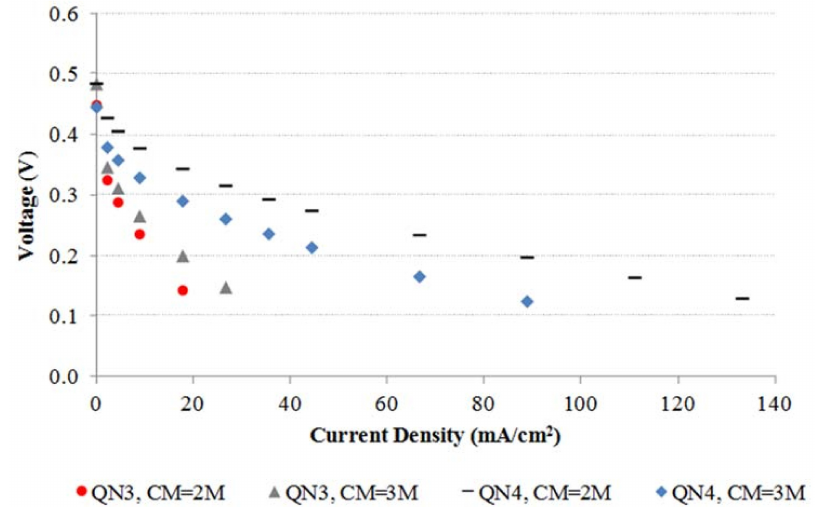
Figure 3. Voltage polarization curves comparison for MEAs QN3 and QN4 for different methanol feed concentrations (CM). Operating conditions: temperature, 25 ◦ C; pressure, 1 atm; methanol/air flow rates, 0.11/130